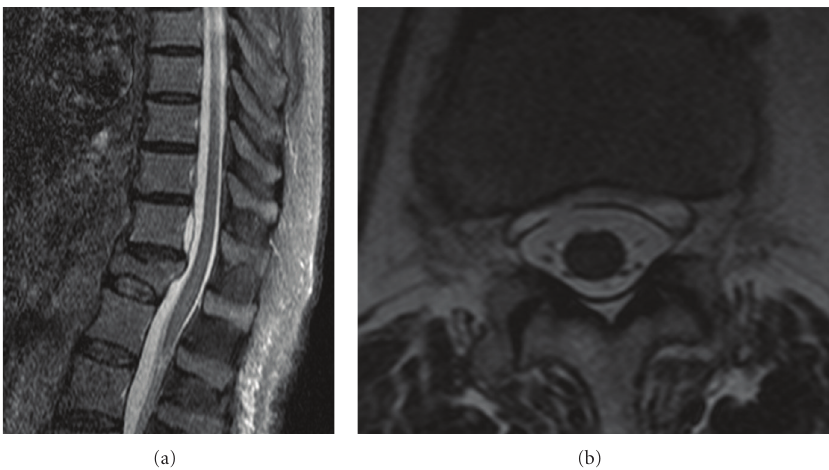
Figure 2: A sagittal STIR MRI (a) reveals an anterior subdural haematoma at T11 level with adjacent fracture and collapse of the 12th thoracic vertebral body, probably due to trauma. In this T2-pondered axial slice (b) there seems to be continuity between the haematoma and the subarachnoid space.